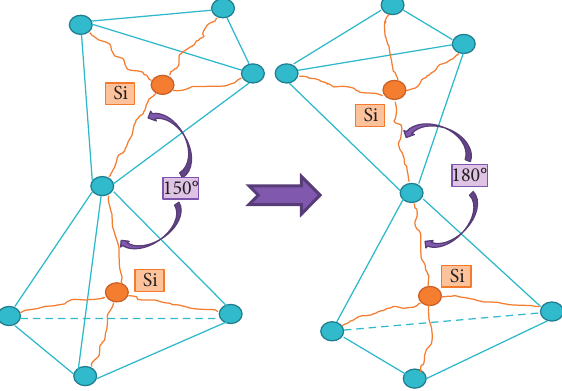
Figure 8: Sketches of the α-β quartz bond